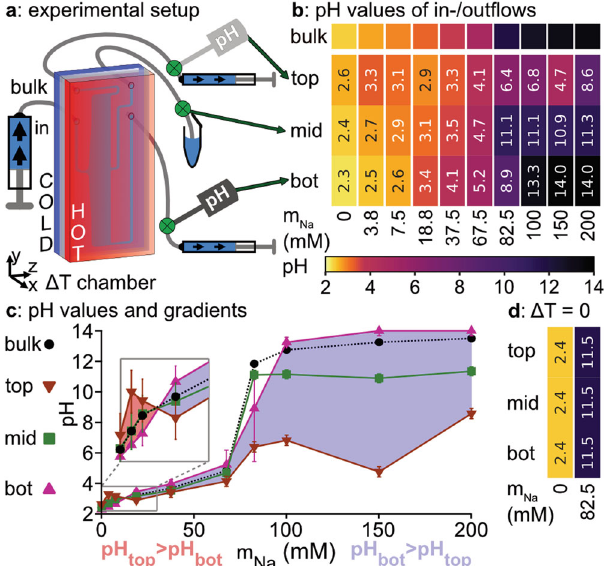
Fig. 2 Experimental setup and results. a Experimental setup. The thin thermal reaction chamber is continuously supplied with a premixed solution containing varying concentrations of formic acid and sodium hydroxide. The out fl ux is split into three parts (top 12%, middle 76% and bottom 12%) and the pH value of each fraction is measured (green circles). For experimental details see Methods. b These pH values are depicted for 75 mM formic acid Fig. 1 Heat fl ows create pH gradients in acid-base mixtures. a Dominant and varying concentrations of NaOH (m Na ) for the inlet (bulk) and the dynamic processes in a heat fl ux chamber: Chemical reactions different outlets. While the bottom fraction qualitatively follows the bulk, (gray) remain locally equilibrated ( τ chem ≲ 10 − 3 s). Thermophoretic especially the top fraction displays a complex, concentration-dependent horizontal accumulation ( τ phor ~ 10 2 s, orange arrows) is faster than vertical behavior both for its value and for the resulting pH gradient Δ pH ð Þ vert Rayleigh-Bénard convection ( τ conv ~ 10 4 s, green arrows), given the high between top and bottom of the heat fl ux cell (measurements for other aspect ratio (height/width) of the heat fl ux chamber that mimics, e.g., a formic acid concentrations shown in Supplementary Fig. 2). c When rock fi ssure. Thermophoresis and convection combined drive a selective plotting the pH values of the different fractions (black circle: bulk, brown accumulation of molecules. Their net accumulation is proportional to their inverted triangle: top, green box: middle, pink triangle: bottom), a positive effective Soret coef fi cient S eff ; 0 , derived in the main text. b Heat fl ows H gradient (pH top > pH bot , red) for low concentrations of NaOH is observed across rock fi ssures provide a non-equilibrium environment that drives which is inverted (blue) at higher concentrations of NaOH and increases proton gradients. By analyzing local out fl ows with standard pH-meters, we massively when m Na > m HCOOH . Error bars are shown as discussed in measure the pH values quasi in situ. c By tuning the concentrations of acids Methods. d In the absence of a temperature gradient, no pH gradient forms and bases, both amplitude and direction of the created pH gradient can be (m HCOOH = 75 controlled.